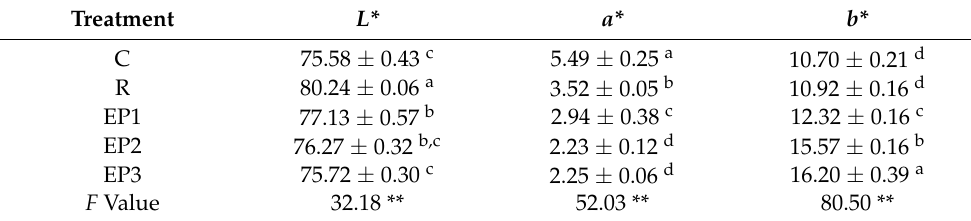
Table 4. Colour parameters ( L* , a* and b* -value) of pork sausages.